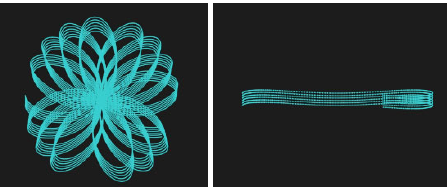
Figure 3: Non-repetitive circular scanning (left) and repetitive line scanning (right) with the L1 laser scanner (LIVOX